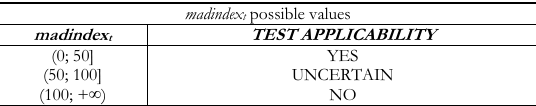
Admissible values of “madindex t ” for test.AV